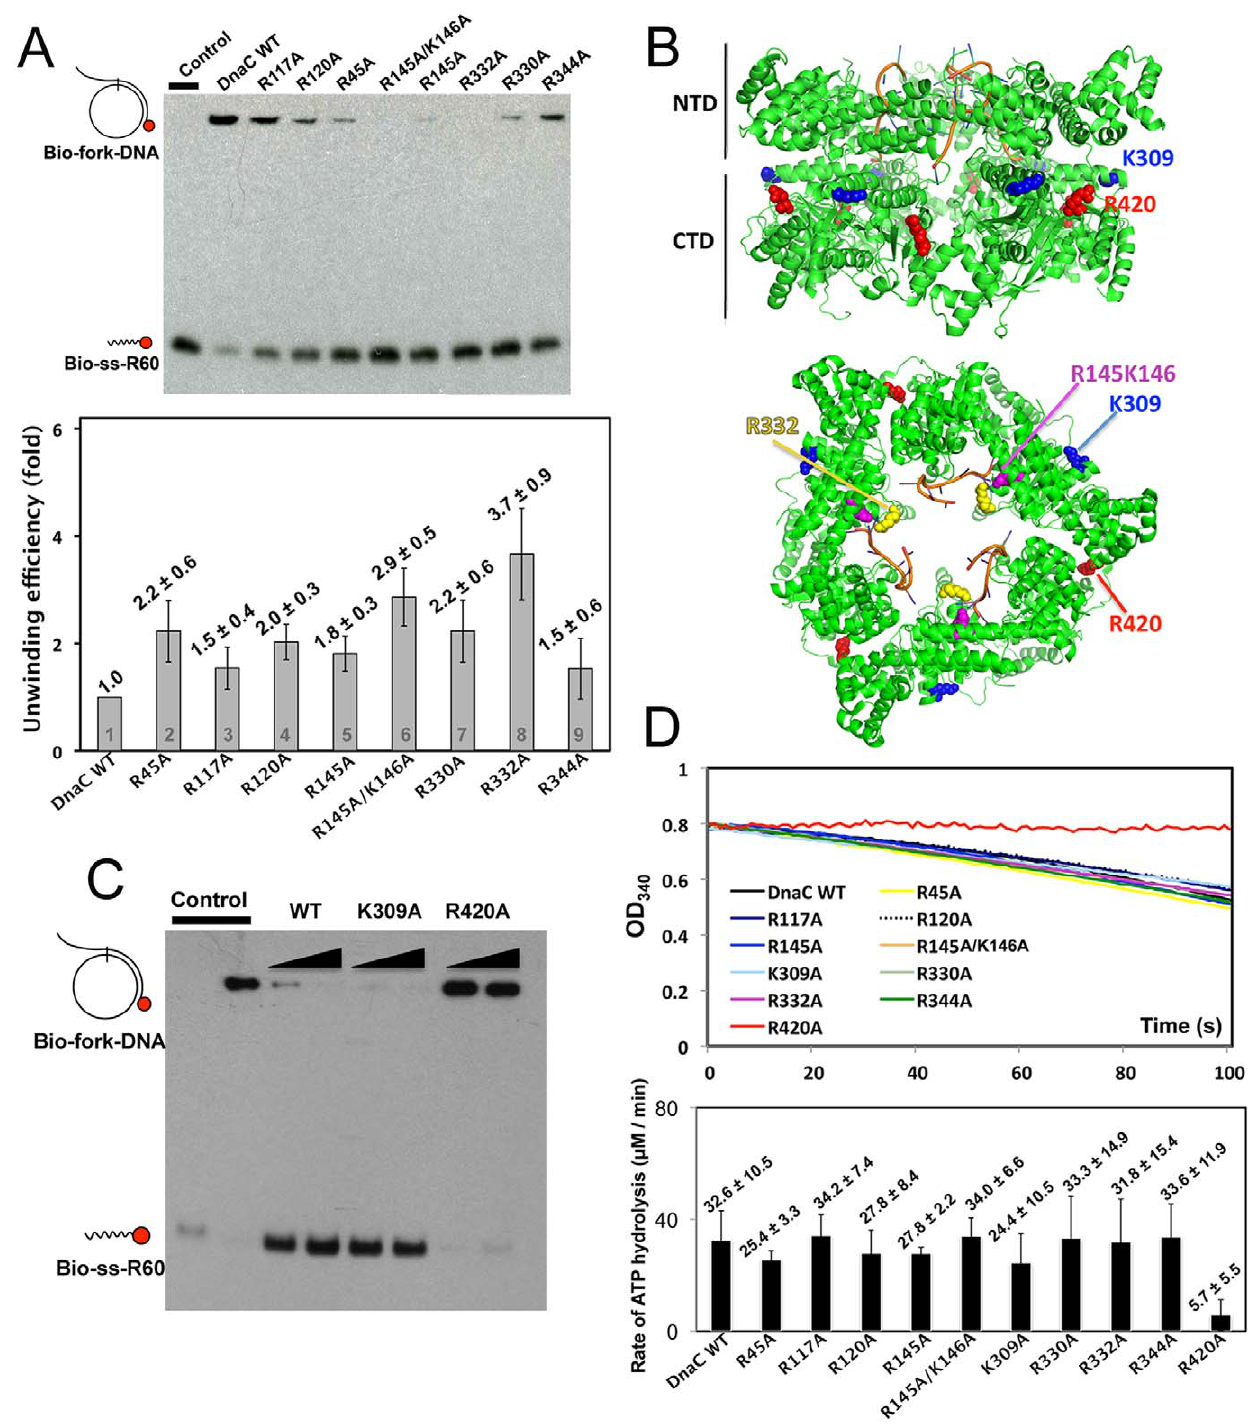
Figure 1. Ensemble assays of wild-type and mutant Gk DnaC. A. Gel shift assay of Gk DnaC WT and mutants. The enhancement of unwinding efficiency is expressed by the fold of change in the biotin-labeled ssDNA unwound product from Gk DnaC mutant to that from WT. Fork-DNA substrate and ssDNA product are indicated schematically on the left. The relative amount of unwinding efficiency of each mutant with reference to Gk DnaC WT is indicated. The red sphere denotes the biotin-labeled end. The average and standard deviations of three independent experiments are given. B. Locations of amino acid residues in Gk DnaC that were mutated. The hexameric Gk DnaC and ssDNA are represented as cartoons and colored in green and orange, respectively. C. Gel shift assay of Gk DnaC WT, mutant K309A and R420A (arginine finger). An increasing amount of purified protein (0.5 to 1 m M) was used in the standard gel shift assay. D. Time-courses of ATPase activity of Gk DnaC WT and mutants. Reactions were initiated by the addition of 1 m M enzyme (per monomer) after preincubation of all other components at RT for 5 min. ATPase rates of WT and mutants are compared. Data represent the average and standard deviations from three independent experiments.